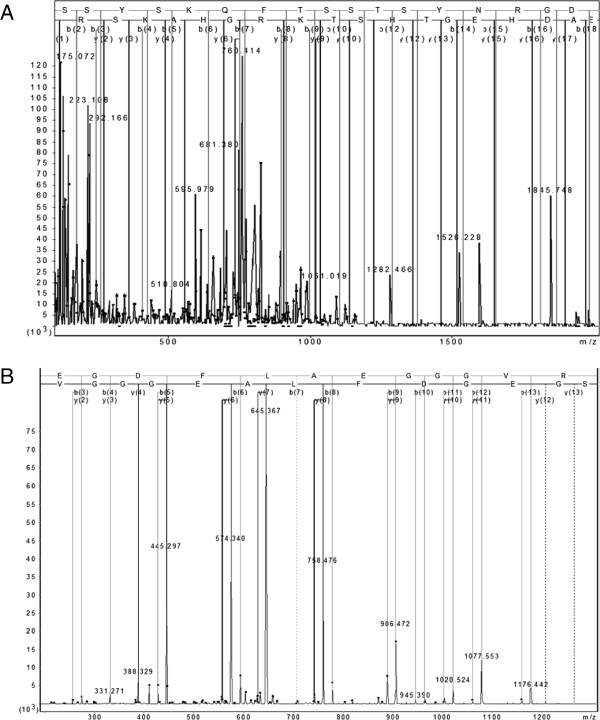
MS/MS fragmentation and sequence data for identified peptides. A. The m/z 5805.0 peak (SSSYSKQFTSSTSYNRGDSTFESKSYKMADEAGSEADHEG-THSTKRGHAKSRP) was identified as a fragment of isoform 1 of fibrinogen alpha chain (IPI00021885) with an ion score of 122 from m/z [726.214]8+. The spectrum shown is the sum of 28 scans in range 130 (rt = 22.952) to 198 (rt = 31.9511). B. The m/z 1350.8 peak (SGEGDFLAEGGGVR) was also identified as a fragment of fibrinogen alpha chain with an ion score of 95 from m/z [675.82]2+.